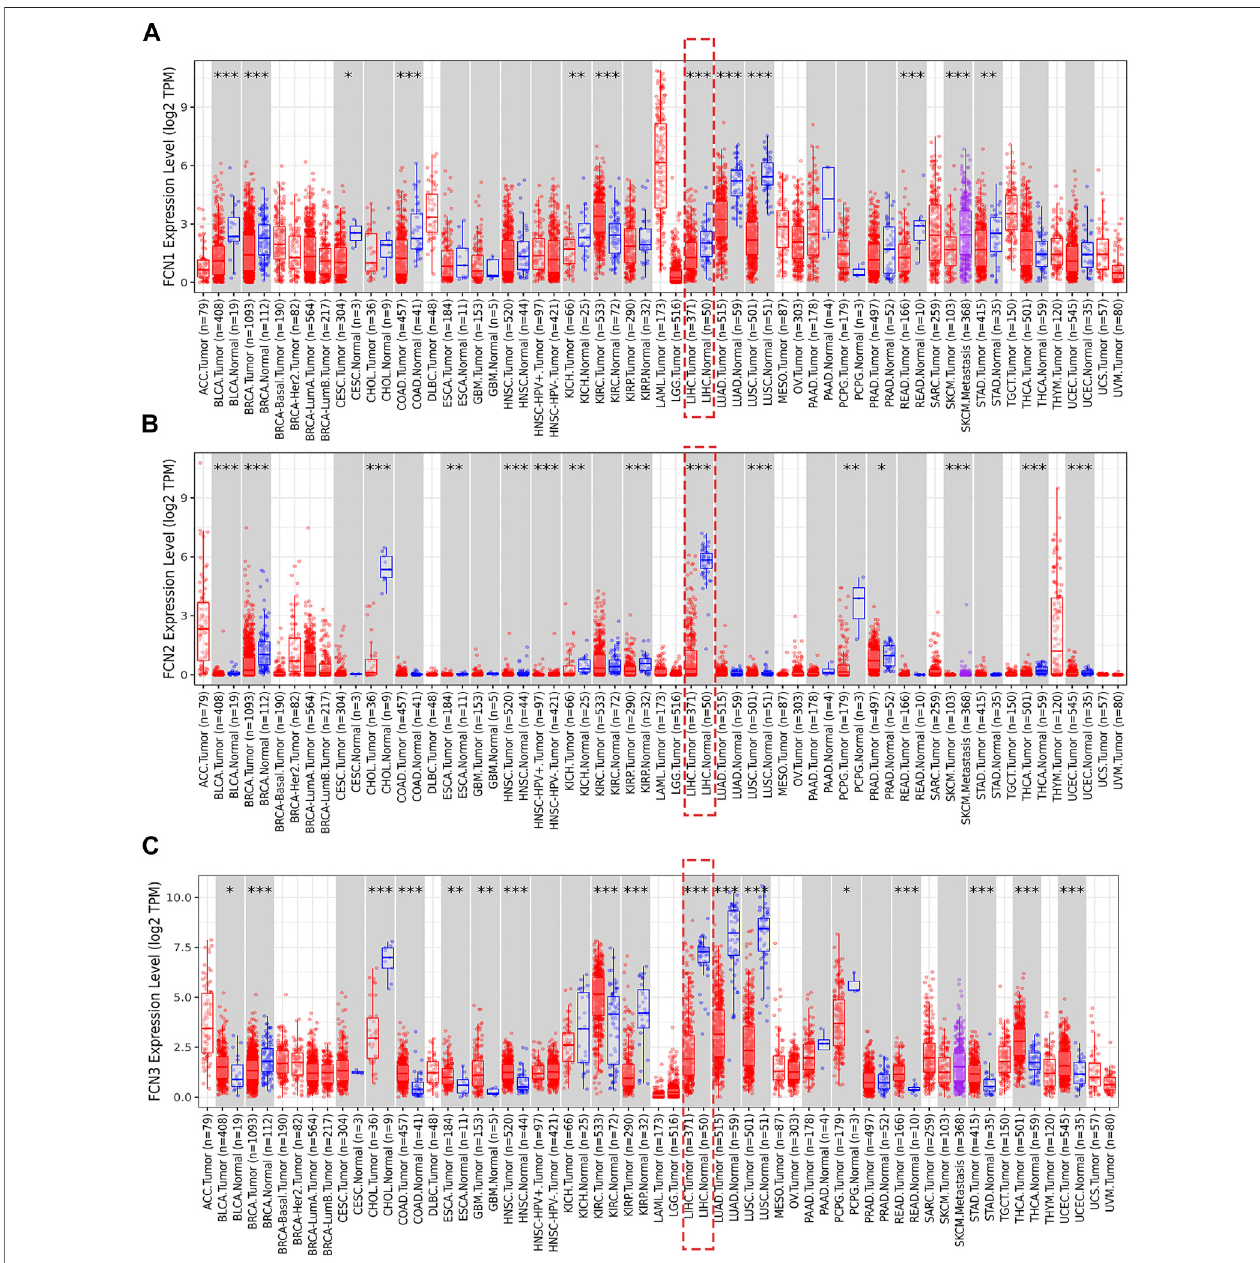
FIGURE 1 | The expression levels of FCNs in different tumor (TIMER). (A) FCN1; (B) FCN2; (C) FCN3.